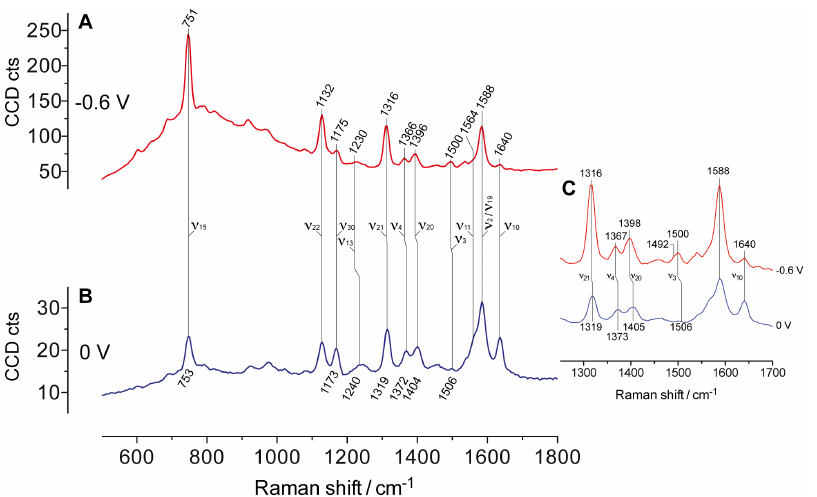
Figure 2. Typical Resonance Raman spectra of electroactive biofilm in the marker region between 550 and 1800 cm 2 1 obtained under different electrode polarizations in the absence of metabolic electron donor. A) RR spectra obtained with the working electrode poised at 2 0.6 V vs. Ag/AgCl. B) RR spectra obtained with the working electrode poised at 0 V vs. Ag/AgCl. C) Detail on RR spectra in the region 1250–1700 cm 2 1 . For clarity, the intensity of the spectra acquired at 0 V is multiplied by 2.